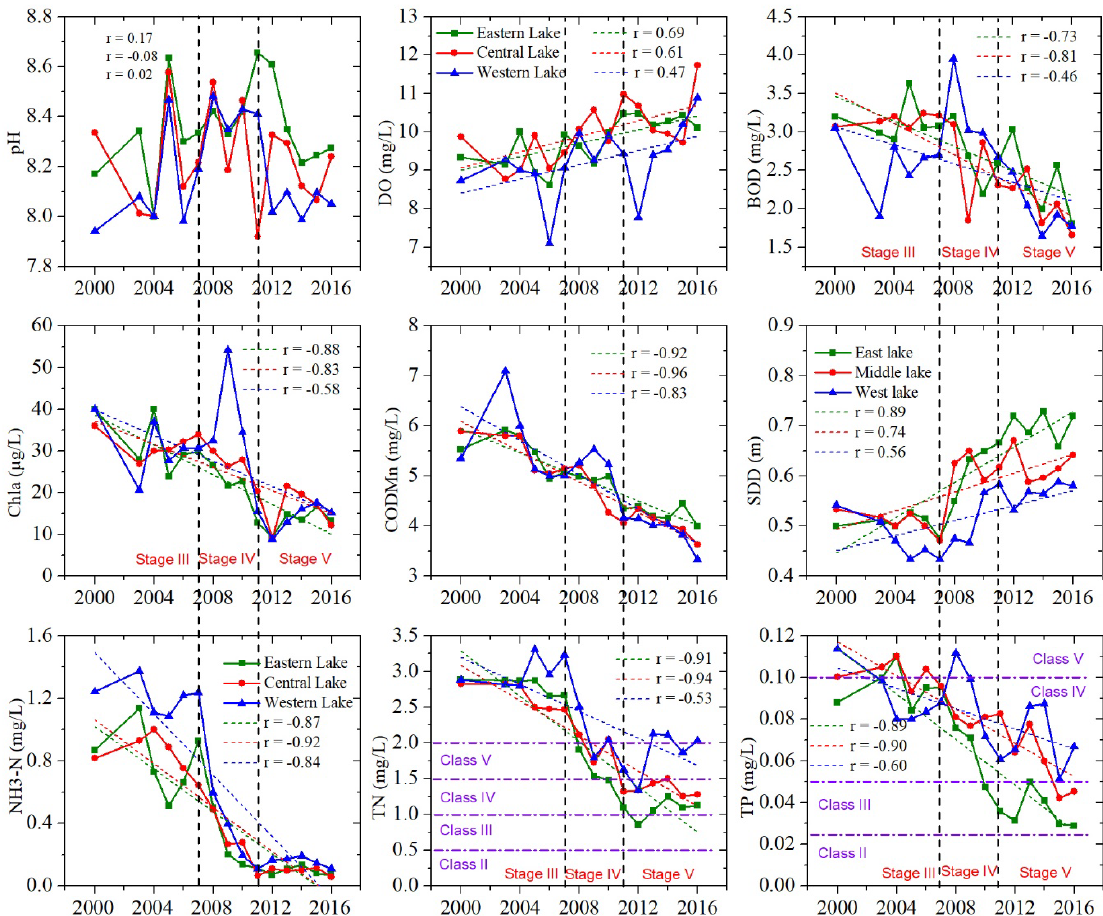
Figure 7. Change trends of water quality parameters from 2000 to 2016 in the Western, Central and Eastern Lakes. The colored dashed lines are trendlines and r is the correction coefficient. The trendlines were drawn only if the p- value < 0.05. A positive r and p- value < 0.05 represent a significant increasing trend over time and a negative r and p- value < 0.05 represent a significant decreasing trend over time. p- value > 0.05 shows no monotonic change.